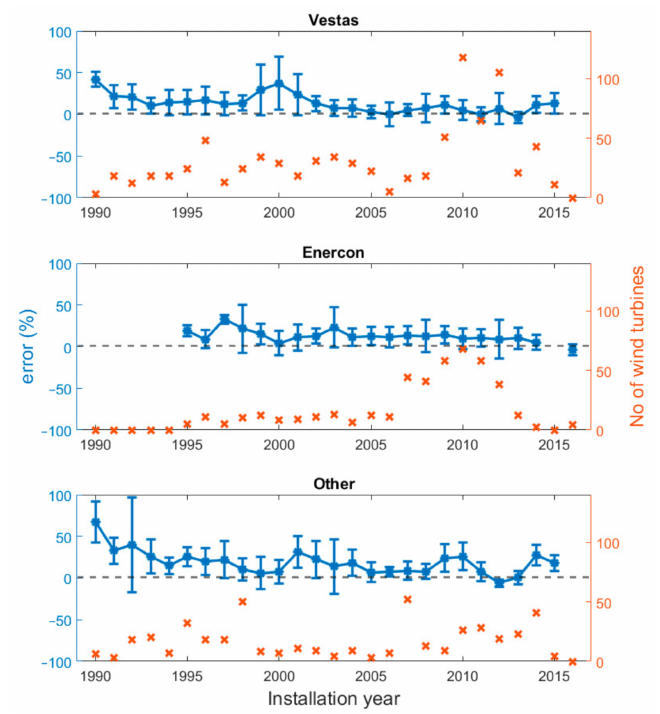
Figure 7. The time development of the AEP prediction accuracy divided on manufacturer with number of wind turbines for each